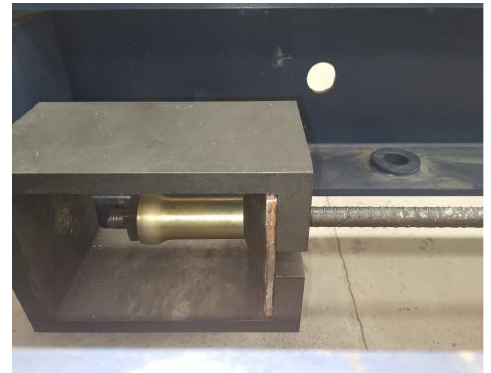
Figure 6. The energy absorbing anchor static load tensile test.